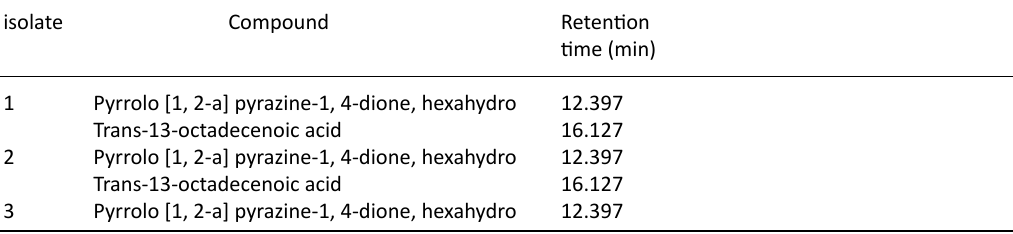
Table 5. Gas chromatogram results of the major compounds of the three active isolates isolate Compound